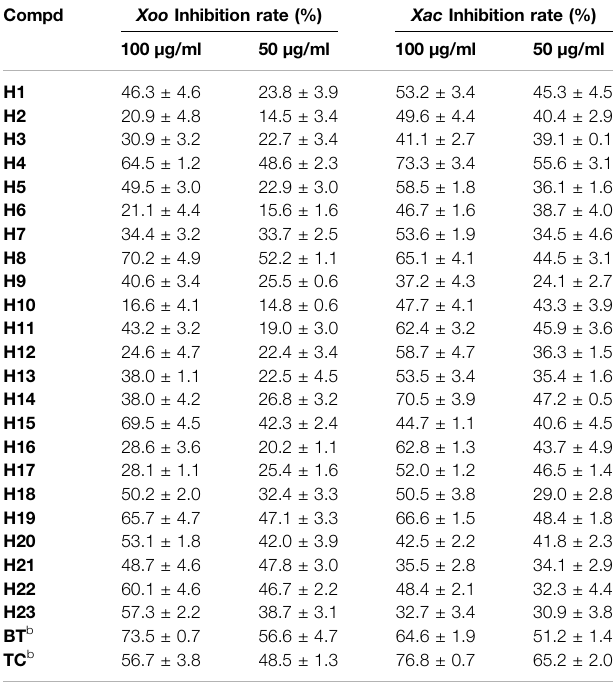
TABLE 1 | In vitro antibacterial activity of the target compounds against Xoo and Xac a